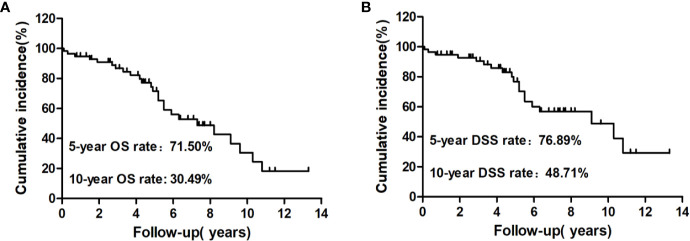
Kaplan–Meier analysis of cumulative overall survival (OS) (A) and disease-specific survival (DSS) (B) rates from the initial diagnosis of distant metastasis to the end of follow-up for these patients.